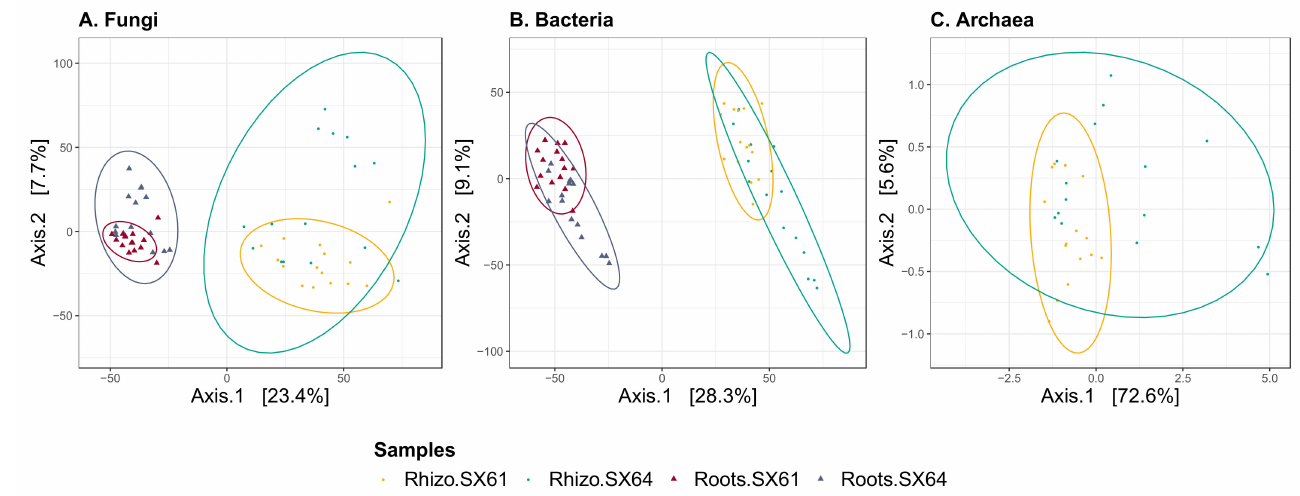
Figure 3. Principal component analysis (PCA) ordinations of microbial communities. Euclidean distances were calculated on the variance stabilizing transformed (VST) ASV counts in each: ( A ) fugal, ( B ) bacterial, and ( C ) archaeal datasets. Shapes (triangle and circle) represent the compartments and colors (red, blue, yellow, and turquoise) represent samples groups. Samples closer together contain more homogeneous communities than samples farther apart. Ellipses were drawn around communities based on a 95% confidence